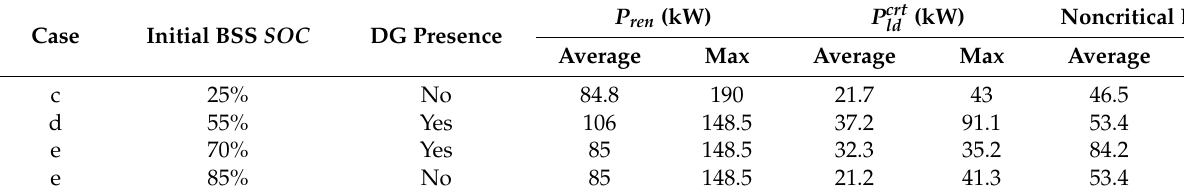
Table 5. Description of details of test cases.